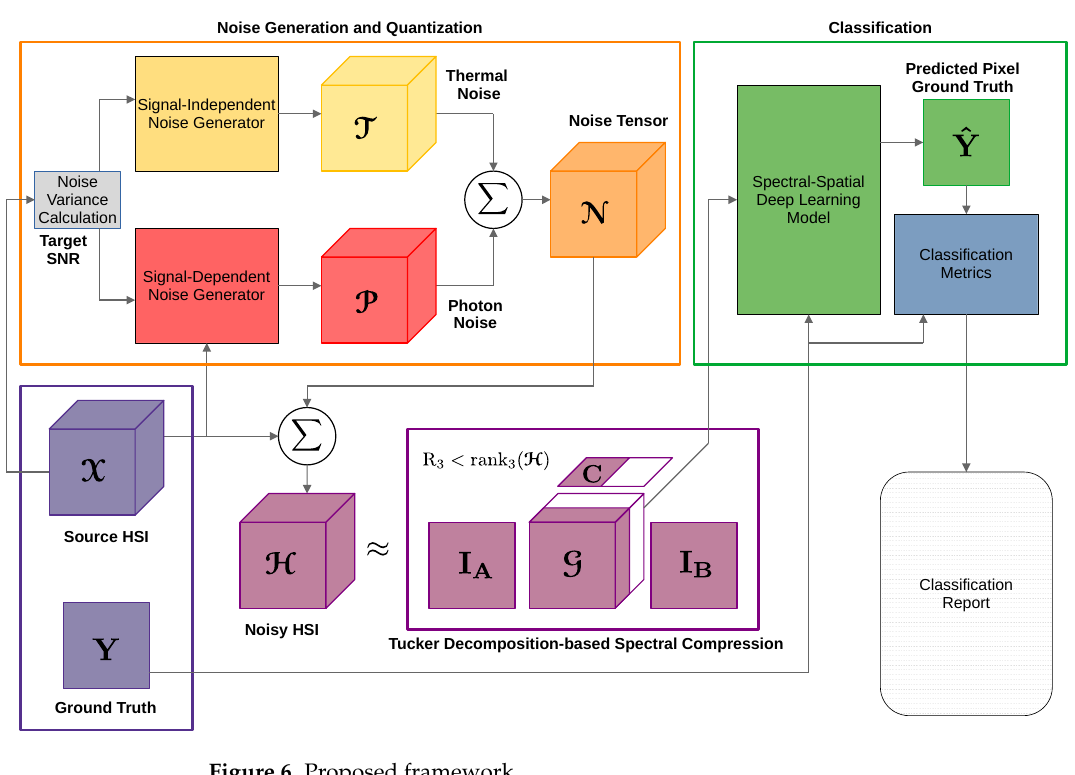
Figure 6. Proposed